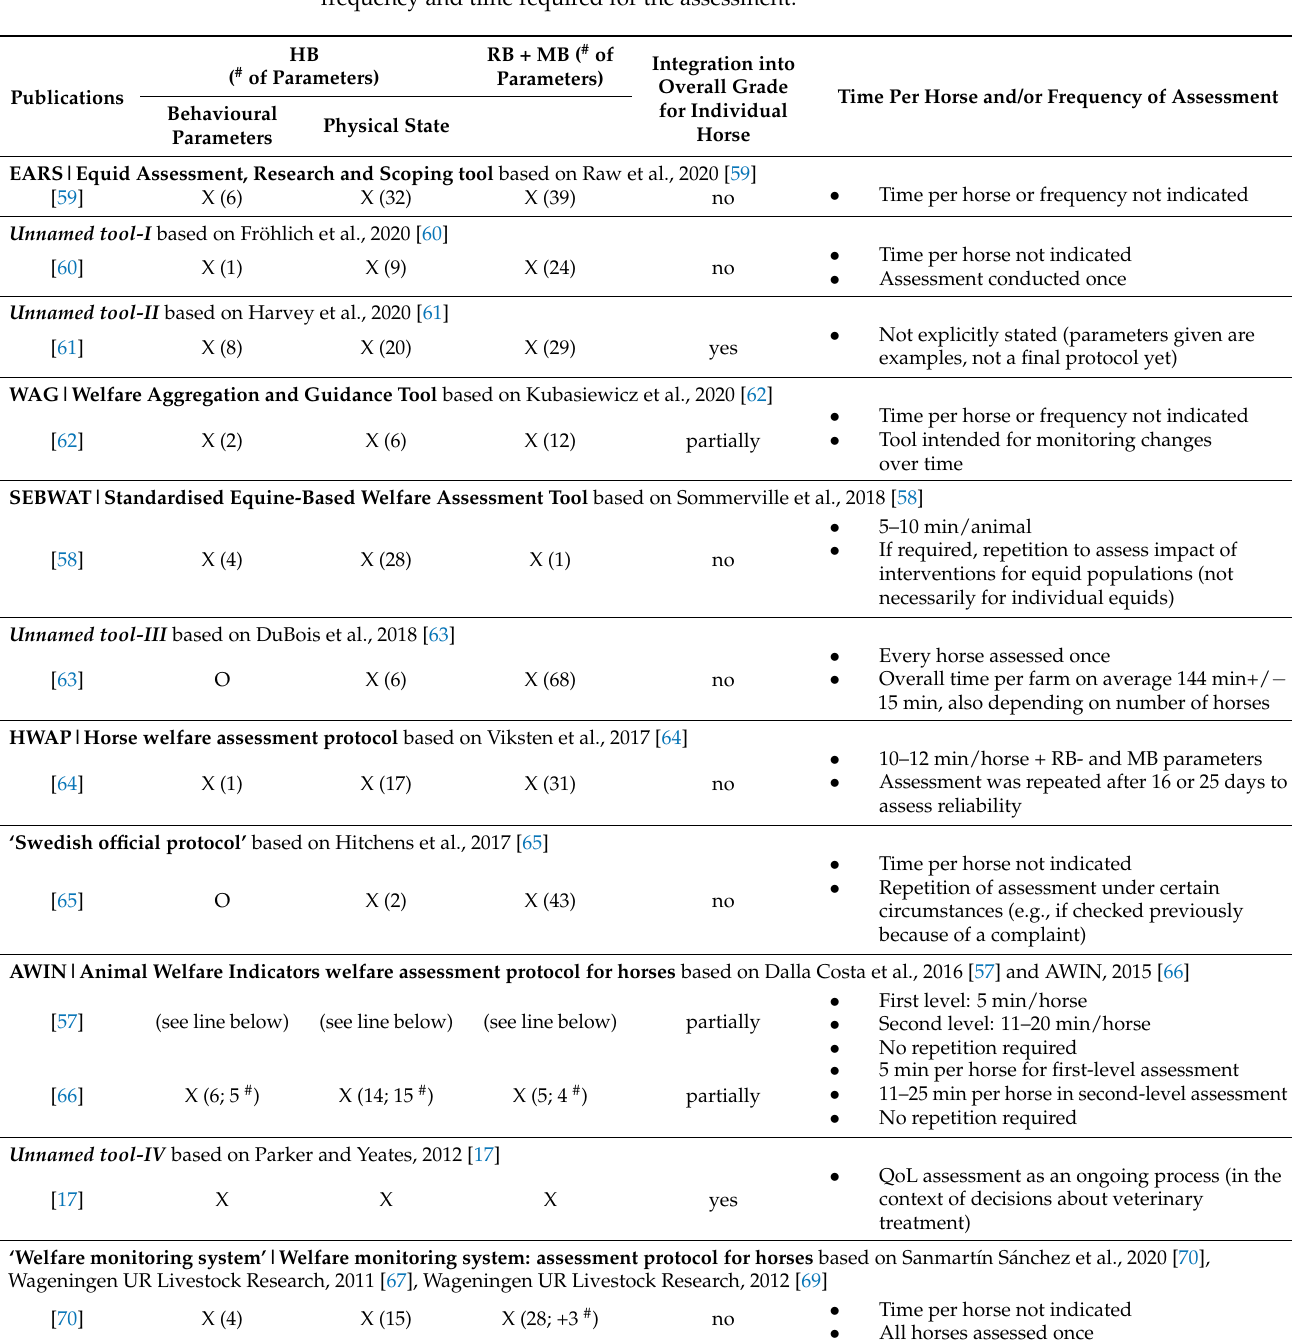
Table 4. Welfare and QoL assessment tools and number of horse-based (HB), resource-based (RB) and management-based (MB) parameters for horses (> 1-year-old), integration approach, assessment frequency and time required for the